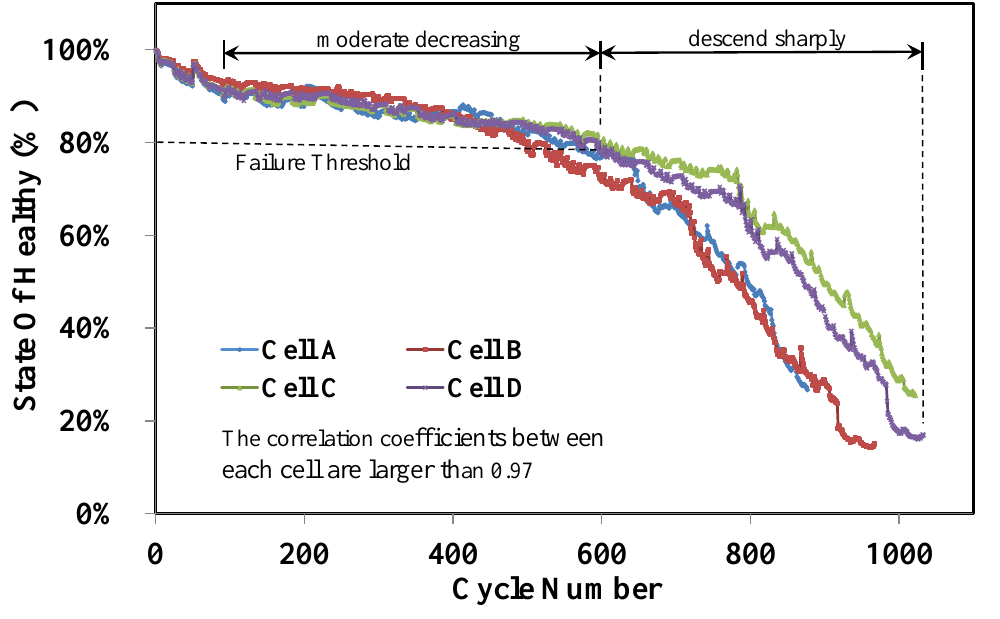
Figure 3. The SOH profiles correlated to N for the four tested